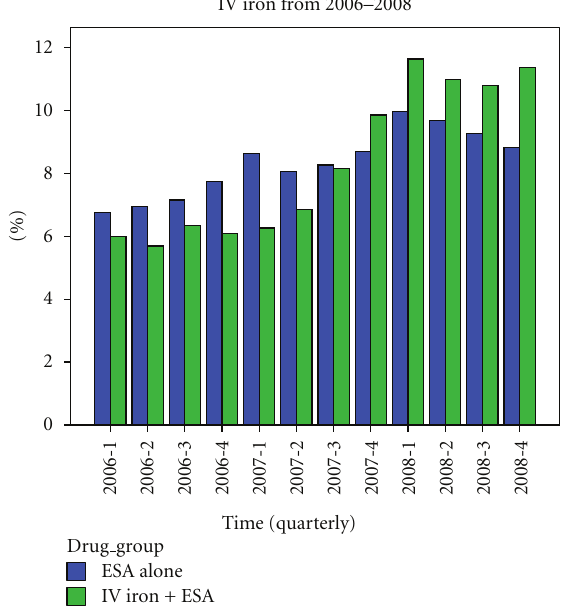
Figure 1: Quarterly percentages of the study population receiving ESA alone and ESA + IV iron from